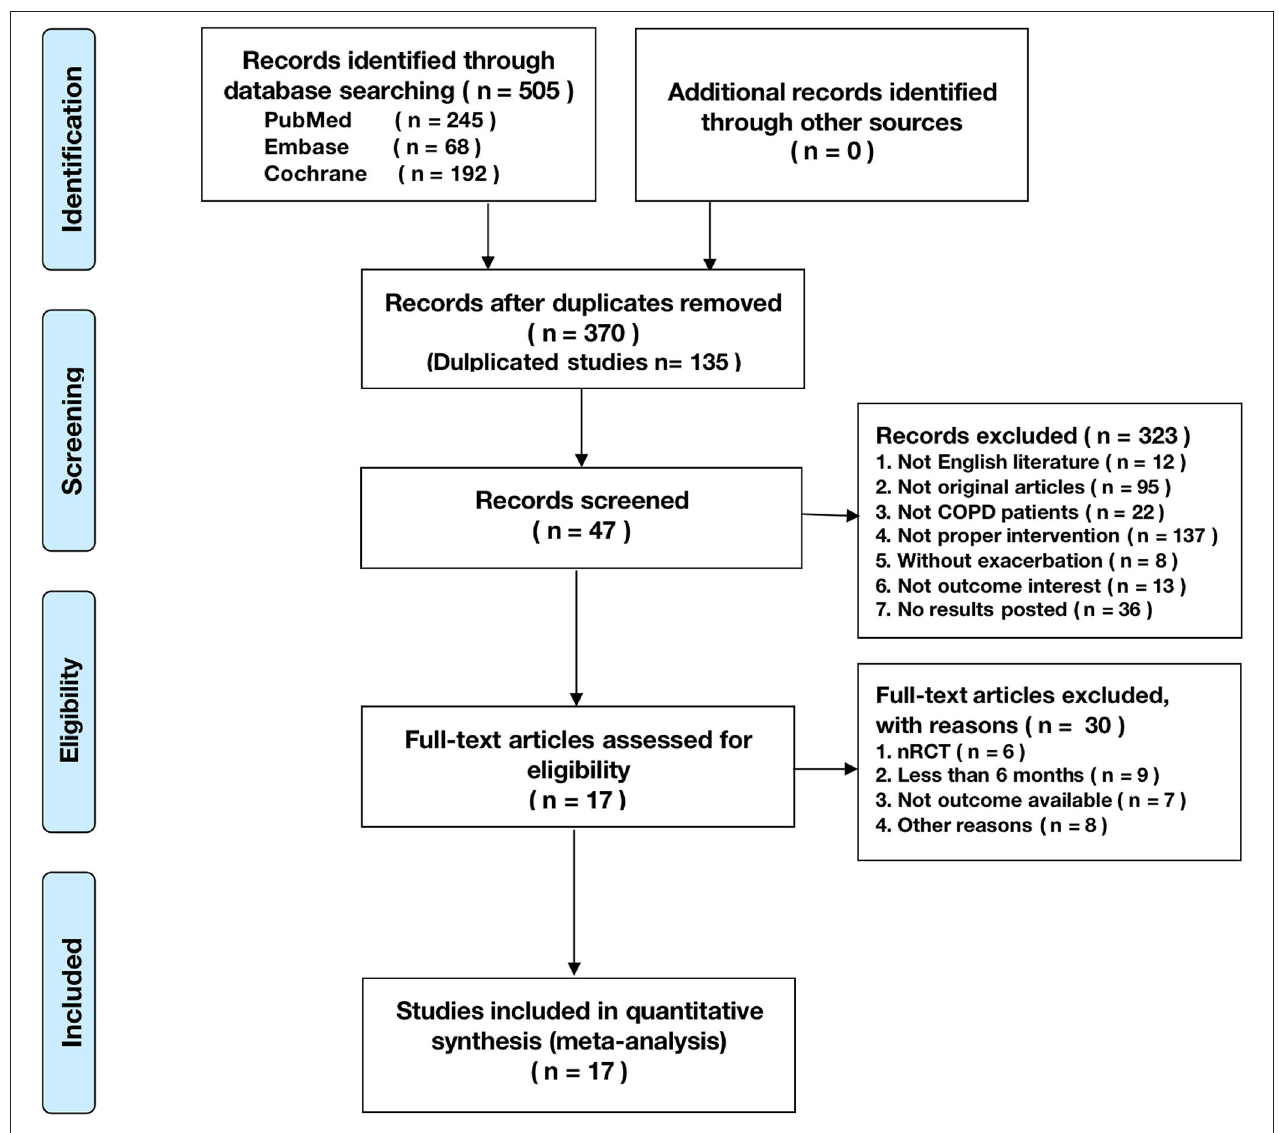
FIGURE 1 | The Preferred Reporting Items for Systematic Reviews and Meta-Analyses (PRISMA) flowchart reporting the number of papers identified, screened, and